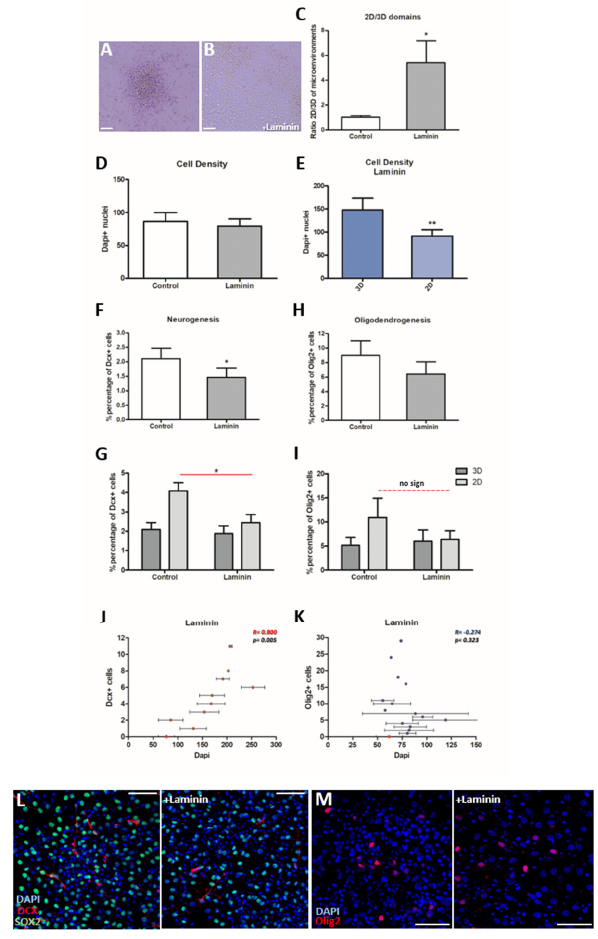
Figure 3 . Effect of laminin on the cytoarchitecture and cell fate of NSCs in the polymorphic neuro- sphere assay. ( A , B ) Characteristic brightfield images of polymorphic NSC cultures after in vitro differentiation in control conditions ( A ) or in the presence of laminin ( B ). Note the change towards a 2D structure in ( B ). ( C ) Graph showing the ratio of 2D/3D domains in the polymorphic assay, after 7d in differentiation, comparing between the “Control” and “+Laminin” groups (* p < 0.05, using paired t -test, n = 7). ( D , E ) Graphs showing the comparison of cell density between “Control” and “+Laminin” groups (in D ) and 3D-2D microenvironments only in the presence of laminin (in E ) (** p < 0.01, using paired t -test, n = 7). ( F , G ) Graphs showing the percentage of Dcx+ cells in the whole culture (in F ) and separate for the different microenvironments ( G ) (* p < 0.05, using paired t -test, n = 4–5). ( H , I ) Graphs showing the percentage of Olig2+ cells in the whole culture (in H ) and separate for the different microenvironments ( I ) ( p > 0.05, using paired t -test, n = 6–7). ( J , K ) Pearson correla- tion analysis for the density of Dcx+ or Olig2+ cells and the total cell density in the presence of laminin revealed a positive correlation for Dcx+ cells ( p = 0.005, r = 0.8, n = 5) (in J ) and no correlation for Olig2+ cells ( p = 0.323, r = − 0.274, n = 6) (in K). ( L , M ) Representative images of NSCs differentiated for 7d with or without the addition of laminin and after immunostaining for different markers. [Er- ror bars: SEM; in ( J , K ) with light red is indicated the average cell density in optical fields with no Dcx or Olig2 positive cells; scale bars: ( A , B ): 20 μ m, ( L , M ): 40 μ m].